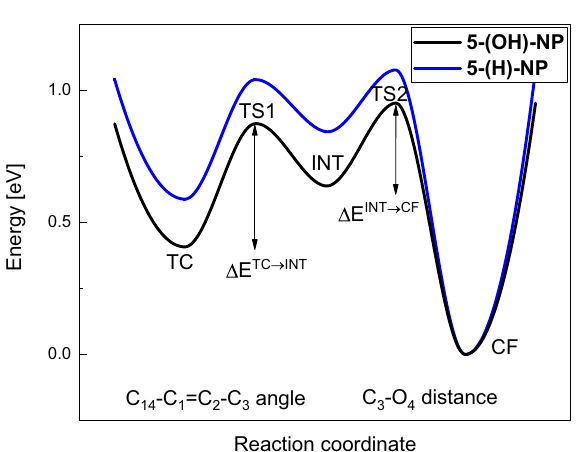
Figure 2. Thermal decoloration of TC → CF for 5-(OH)-NP compound (black line) involves two reaction steps TC → INT and INT → CF (the first step is reversible). S 0 -state potential-energy profiles were computed with aid of the MP2/cc-pVDZ method. The reference compound 5-(H)-NP (blue curve) is traced according to reported data 53